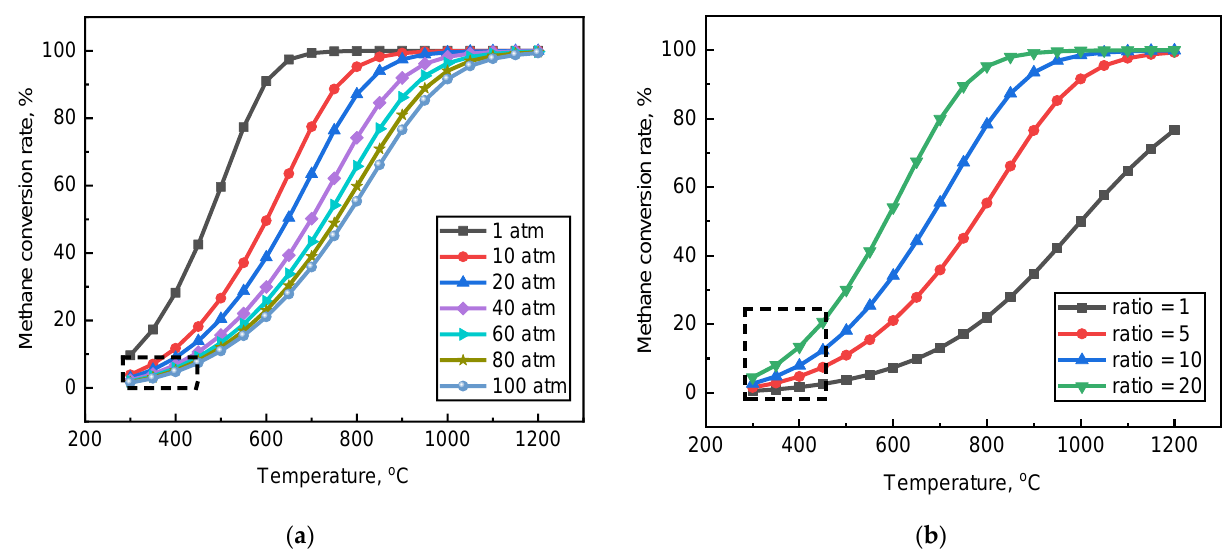
Figure 4. ( a ) The dependencies of methane conversion rates on the temperature at different pressures and constant steam/methane ratio 5 and ( b ) at different steam/methane ratios and constant pressure 100 atm, as a result of thermody- namic calculations for the primary catalytic SMR process.